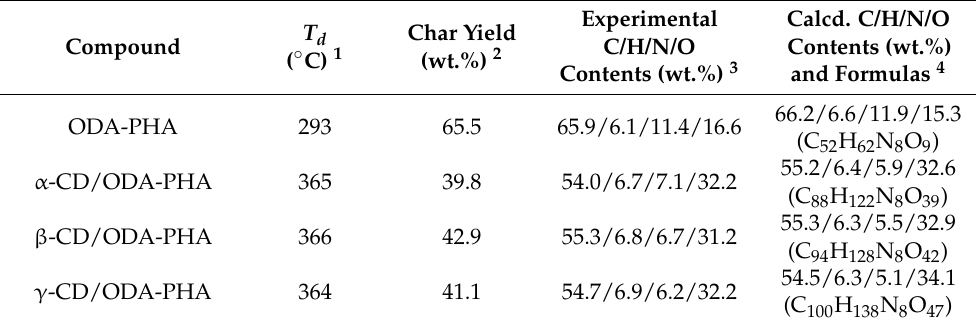
Table 2. Final T d , char yield, and elemental analysis data (based on a hypothetical model) of ODA- PHA and CD/ODA-PHA prepared at an ODA:CD molar ratio of 1:0.5. Experimental Calcd. C/H/N/O T d Char Yield Compound C/H/N/O Contents ( ◦ C) 1 (wt.%) 2 Contents (wt.%) 3